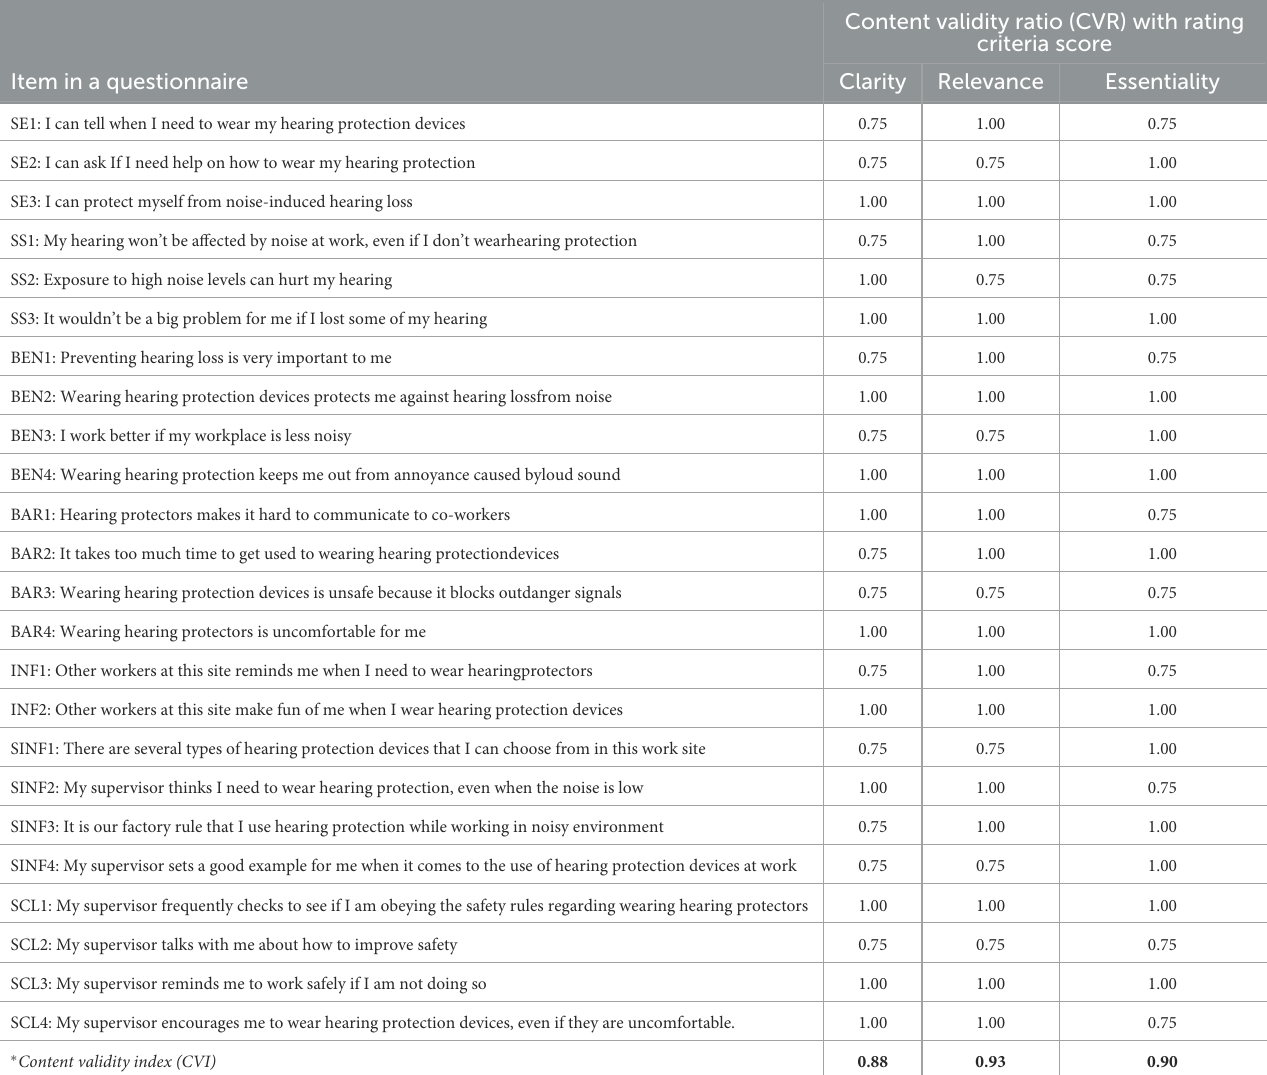
TABLE 3 Scores for Content Validity Index (CVI) and Content Validity ratio (CVR) for items in the HPDs use questionnaire among noise exposed workers in manufacturing factory.